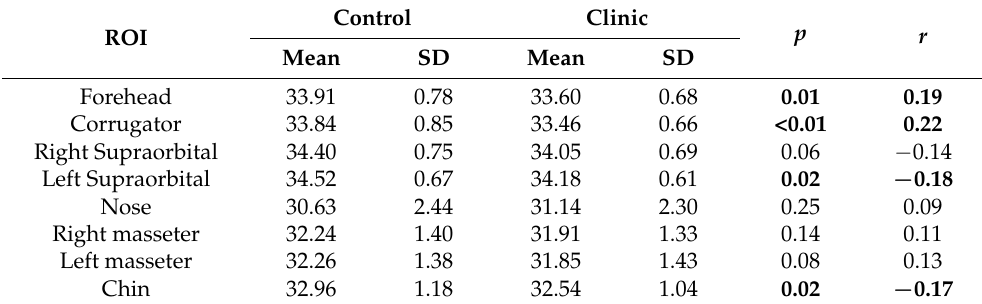
Table 4. Age comparison table.